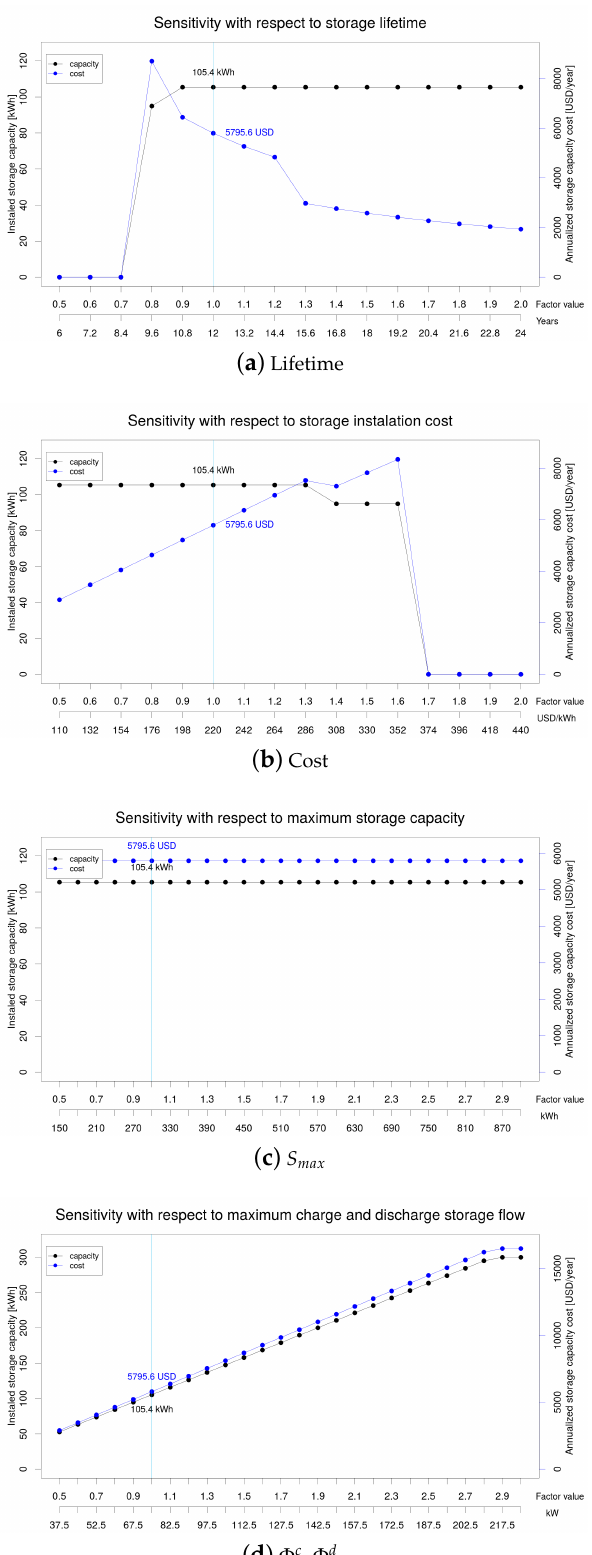
Figure 15. Sensitivity analysis results for four ESS parameters: ( a ) lifetime, ( b ) cost, ( c ) max. storage capacity and ( d ) charge/discharge storage flows. Lines represent the aggregated installed ESS cost and capacity for ZEBRA